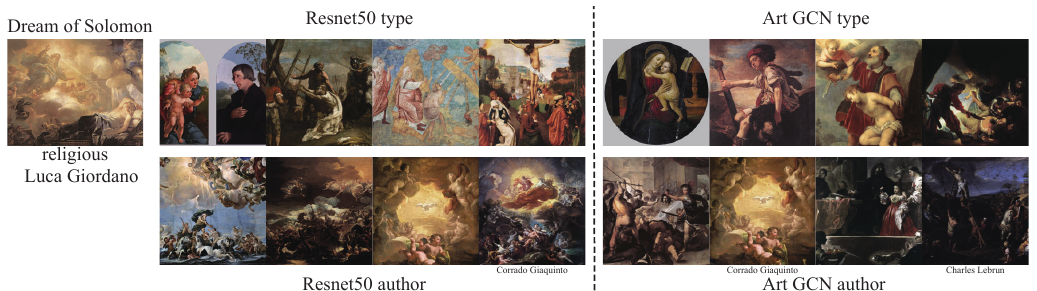
Figure 8. Similarity results for the painting Dream of Solomon, by Giordano, Luca.